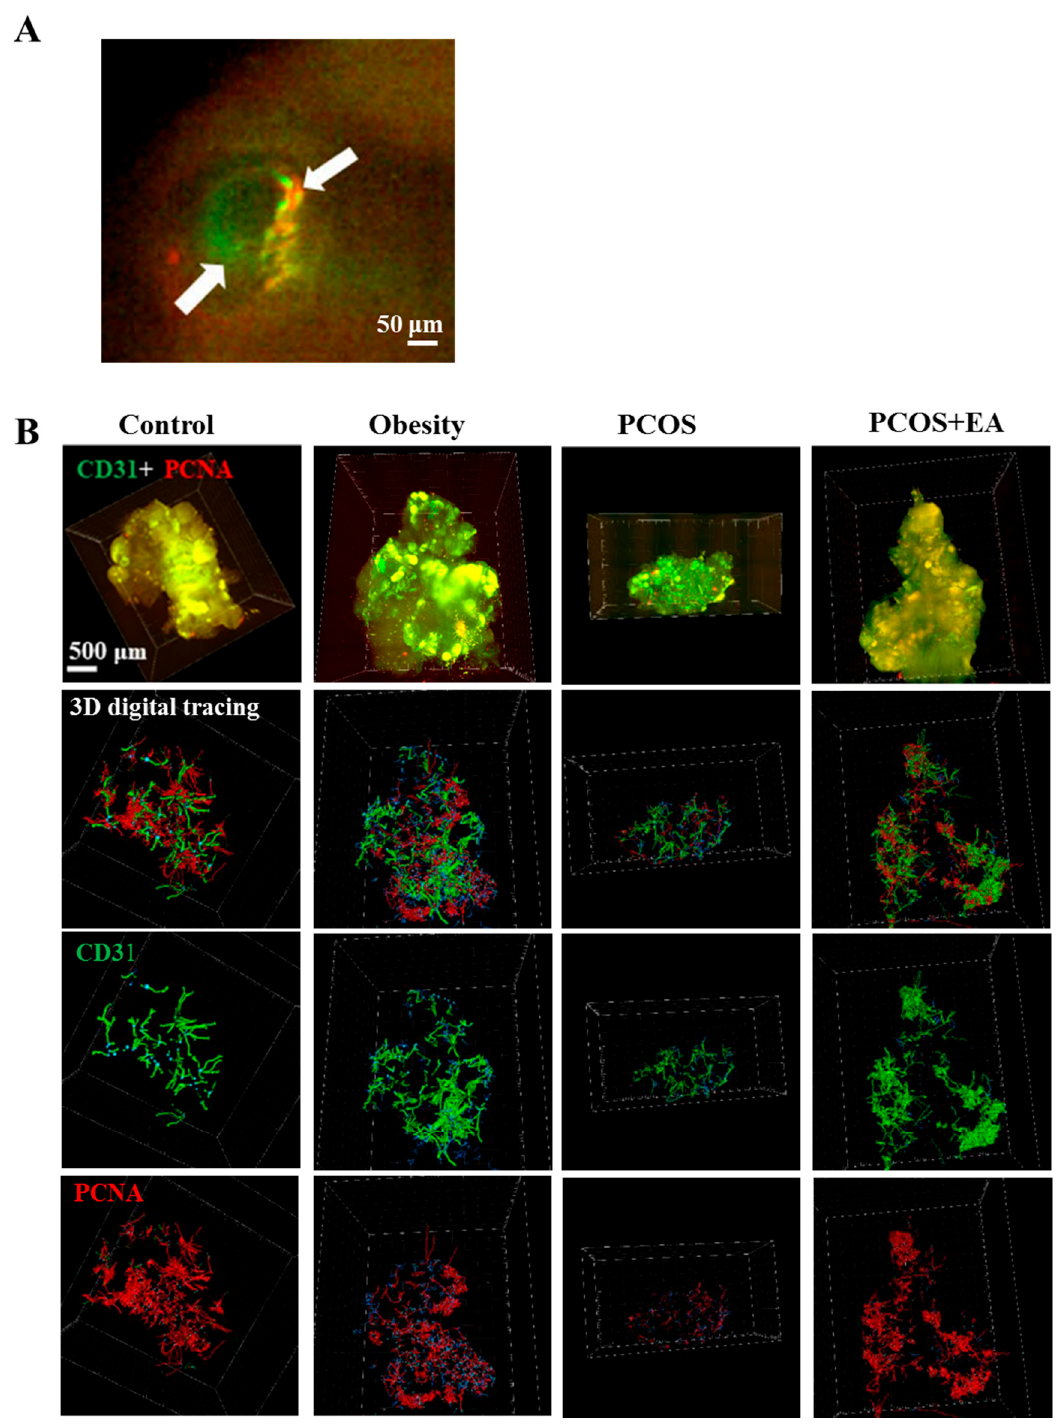
Figure 3. EA promotes angiogenesis in PCOS-like rat ovaries. ( A ) CD31 was used to stain the vasculature, and proliferating cell nuclear antigen (PCNA) was used to stain the neovasculature. The white arrows indicated the co-localization of PCNA with CD31 in one follicle. ( B ) Ovaries from rats from different groups after CLARITY processing and immunostaining using specific antibodies, followed by data transformation using the Imaris Filament algorithm. First row: 3D rendering of whole ovary images; second row: vasculature and neovasculature within the ovaries; third row: vasculature within each ovary; fourth row: neovasculature in each ovary.